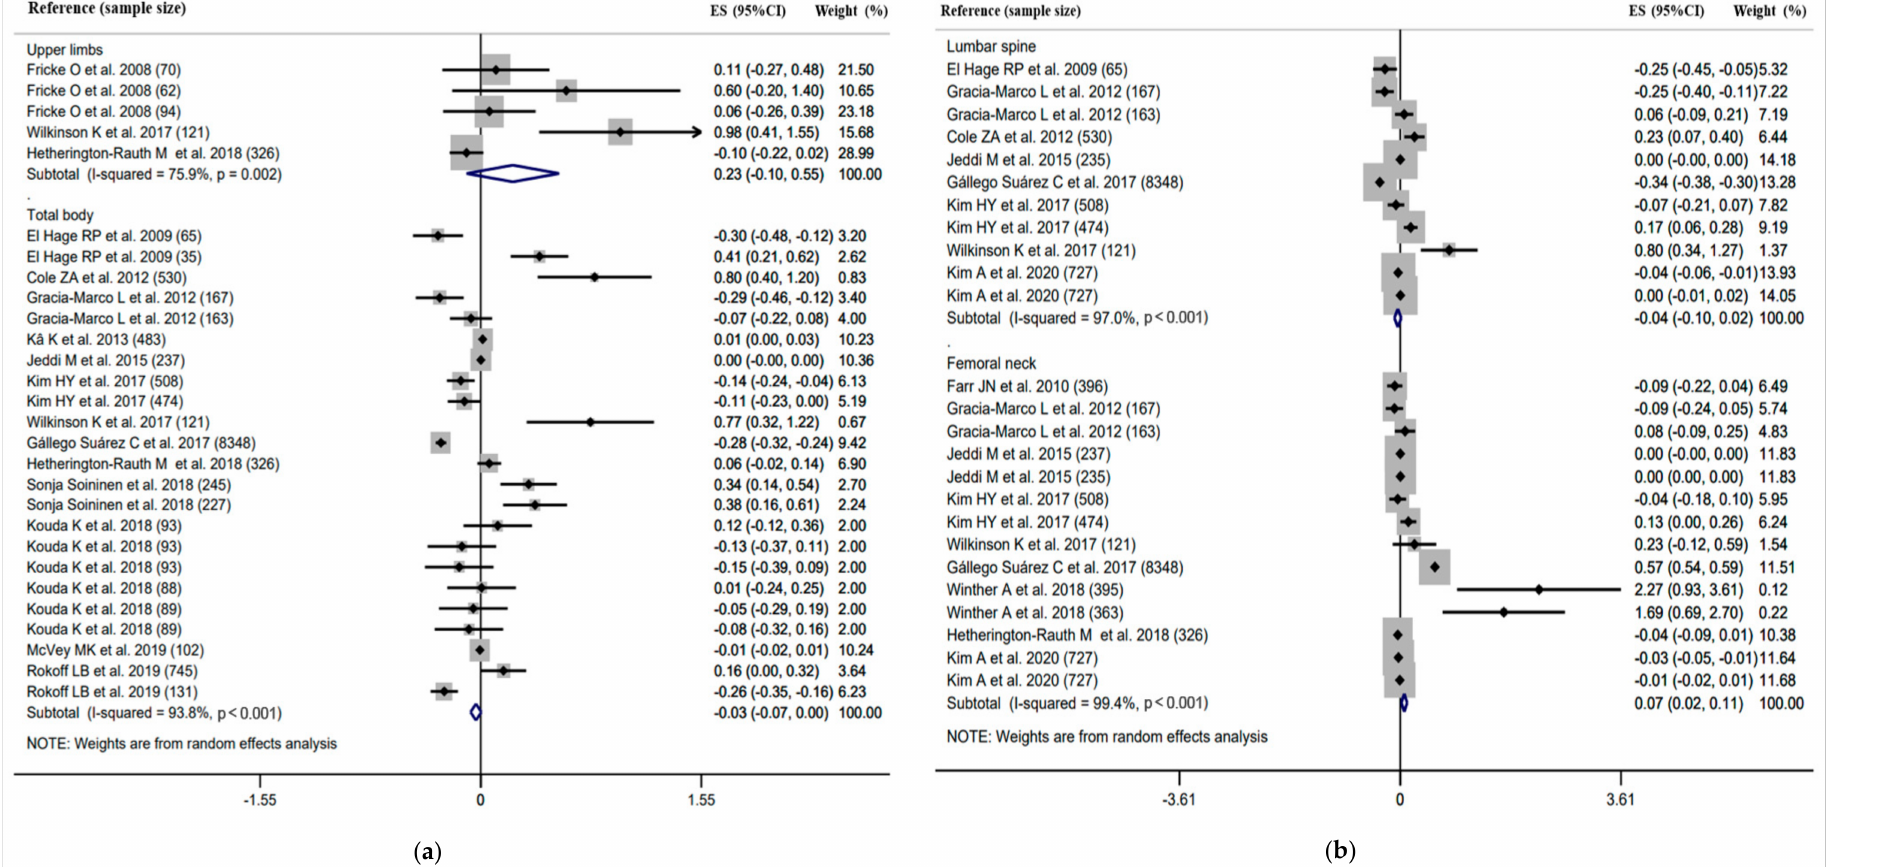
Figure 3. Forest plot of association (regression coefficient) between fat mass (FM) and bone mineral density (BMD) in ( a ) upper limbs, total body, ( b ) lumber spine, femoral neck, respectively. The effect size (ES) and 95% confidence interval (CI) for fully adjusted random effects are depicted for each